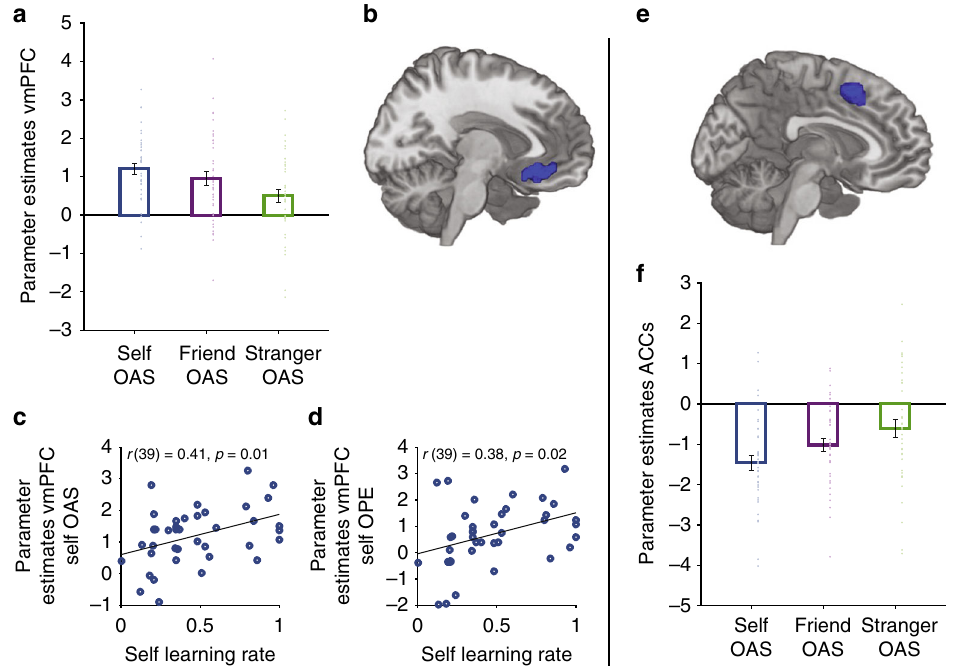
Fig. 4 vmPFC and ACCs track ownership associative strength (OAS) for self more than stranger, but carry signals of all three agents. a vmPFC (area 14 m extending to 11 m) signals covary with OAS for self more than stranger ( p < .05 FWE-SVC), but respond signi fi cantly from 0 in each of the three conditions (all p s < .008). b Cluster overlaid on an anatomical scan of the medial surface. c Bivariate correlations between vmPFC responses to self OAS and the self learning rate and d correlations between vmPFC responses to self OPEs and self learning rate. In both cases, correlations with the self learning rates and neural responses were signi fi cantly stronger than associations between vmPFC responses to friend and stranger and respective learning rates (during the tracking of OAS) and vmPFC responses to stranger and stranger learning rates (during the tracking of OPEs). e Cluster overlaid on an anatomical scan of the medial surface. f Negative ACC signals covary with OAS for self more than stranger ( p < .05 FWE-whole brain), but respond signi fi cantly differently from 0 in each of the three conditions (all p s < .010). Error bars indicate standard error of the mean. N =